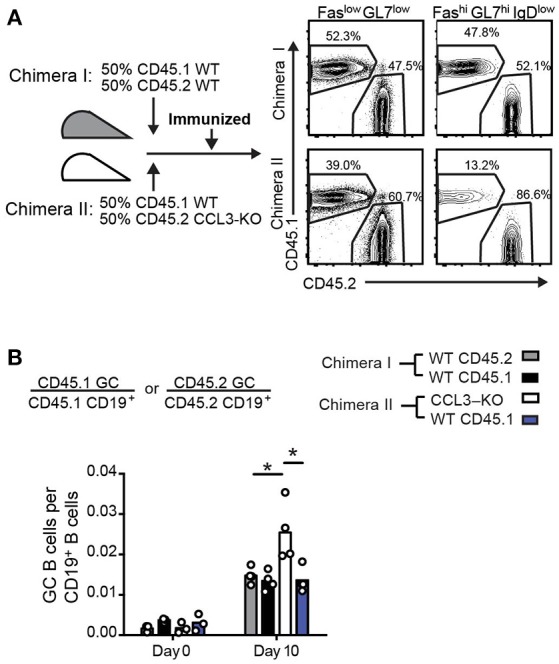
Intrinsic production of CCL3 by B cells is required for their control in GCs in mixed bone marrow chimeras. (A) Experimental outline and generation of mixed 50:50 WT/WT (Chimeras I) and WT/CCL3-KO (Chimeras II) BMChs (left) and example of flow cytometry analysis of total CD19+ cells and GC cells from draining LNs of BMChs on day 10 p.i. with OVA in CFA (right). (B) Flow cytometry analysis of draining LNs at 0 and 10 d.p.i. Fractions of CD45.1 or CD45.2 GC B cells relative to their respective CD19+ B cell population. Data represents four independent experiments. Bars represent means and each symbol represents an individual mouse. *P < 0.05, ANOVA with Dunnet post-analysis.